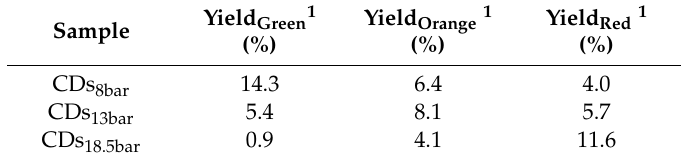
Figure 1. Trend of the pressure registered during solvothermal syntheses for CDs 8bar (green line), CDs 13bar (orange line) and CDs 18.5bar (purple line) ( a ). IR spectra of selected reference fractions of the CDs ( b ): CDs 8 bar (green line), CDs 13bar (orange line) and CDs 18.5bar (purple line). Table 1. Reaction yield of the carbon nanodots (CDs) obtained at di ff erent operating